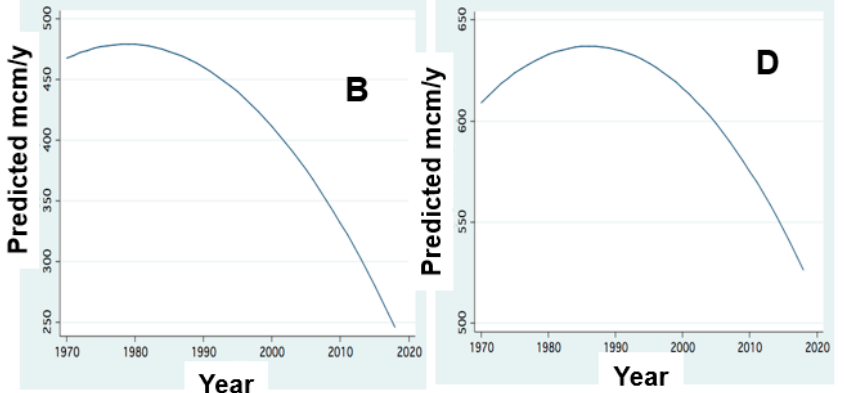
Figure 3. The decline of rainfall and river discharge: ( A , B ) Annual Rain (mm); ( C , D ) Jordan Discharge (mcm/y) ( A , C ) line scatter; ( B , D ) FP regression; Two exceptions: 1991–2: 842 mcm/y; 2003–4: 807 (mcm/y) are indicated. River Jordan are shown in Figures 4–9 [11,12].